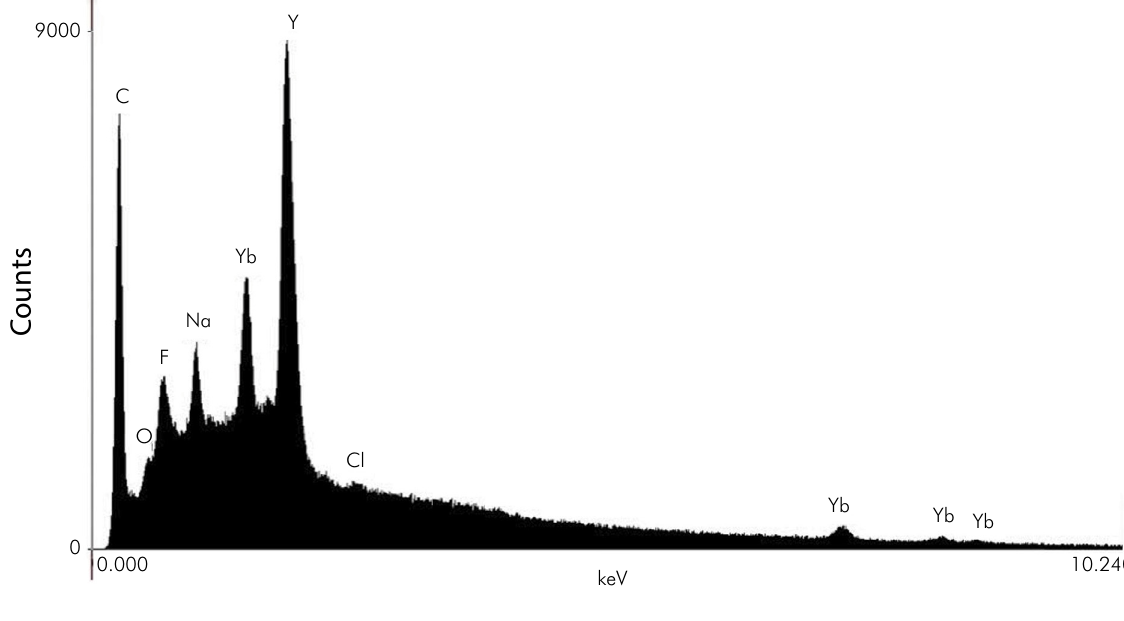
Figure 2. EDX spectrum of the synthetized UCNPs and compositional analysis. The peaks indicate the presence of Carbon Oxygen, Fluorine, Sodium, Ytterbium, Yttrium, and Chlorine elements resulting from the particles